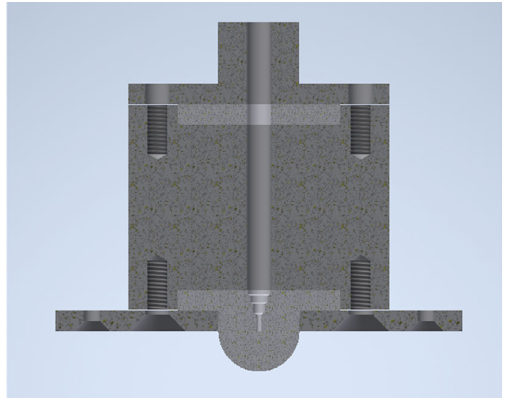
Fig. 9 Cross section of the diffuser capsules. Sections displayed in light grey are made of PTFE, dark grey is 316L stainless steel